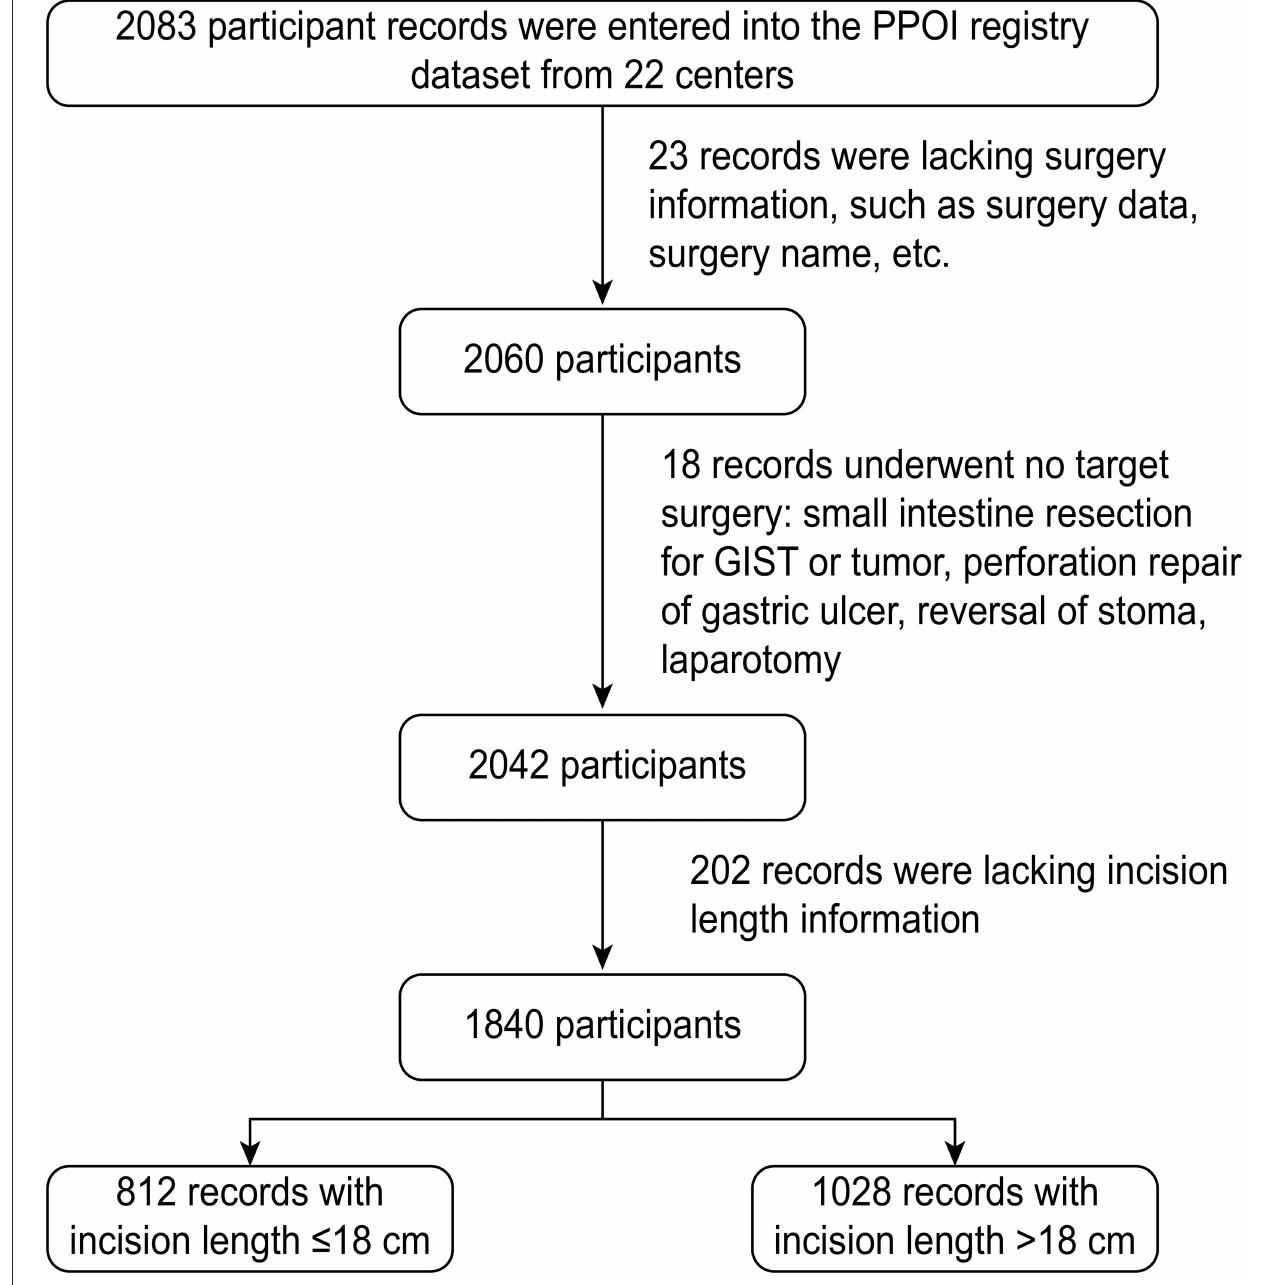
FIGURE 1 | Flowchart of the participants inclusion and exclusion.